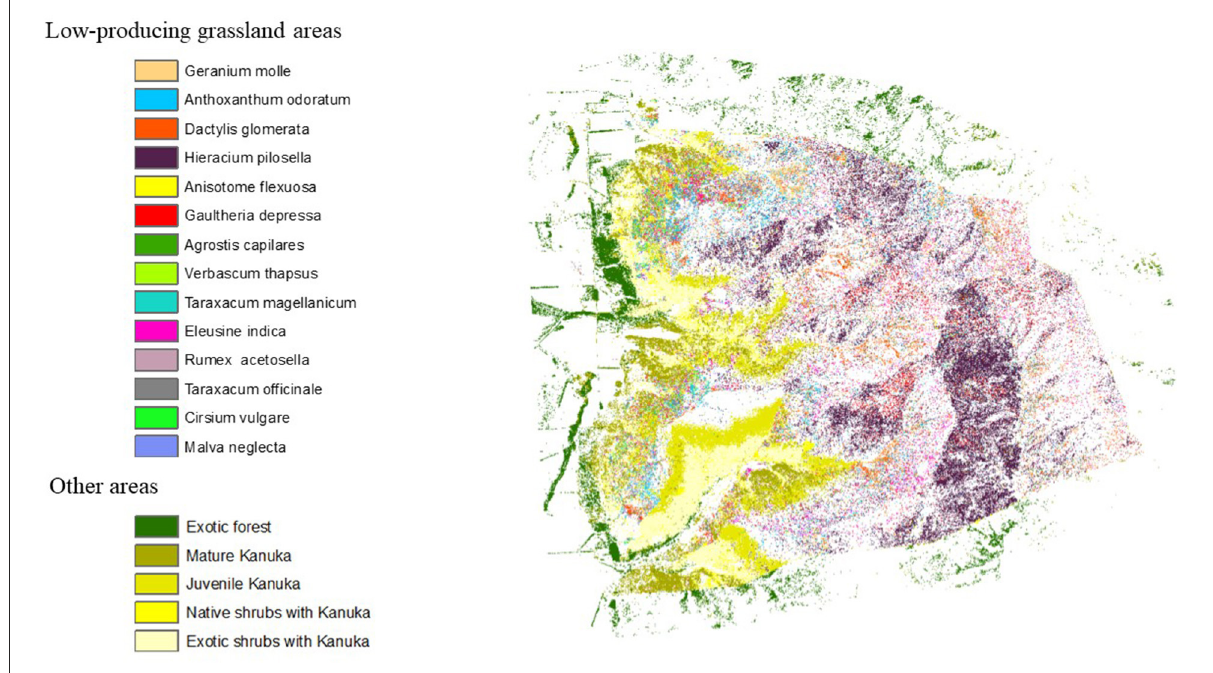
FIGURE3 Healthscape map illustrating distribution and location of phytochemical rich plants with potential medicinal use in